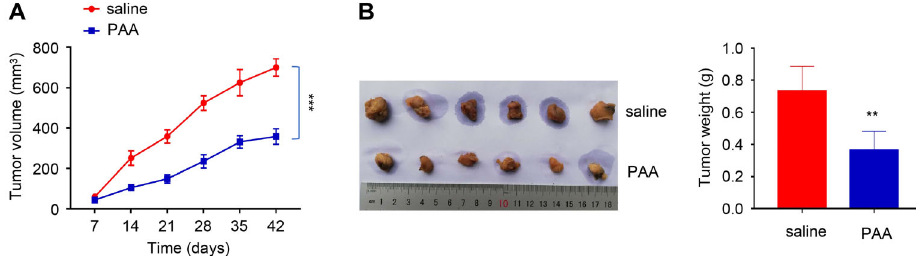
Figure 4. Poricoic acid A (PAA) treatment showed anti-tumorigenesis effects in xenograft model. A , SKOV3 cells were injected subcutaneously into female nude mice. The tumor volumes in mice fed with saline and mice with daily PAA intake were measured at 7, 14, 21, 28, 35, 42 days (n=6). ***P o 0.001, two-way ANOVA with Bonferroni post hoc test. B , Mice were sacri fi ced on day 42 and the tumor weight was compared between saline and PAA treatment groups. Data are reported as means ± SD. **P o 0.01, Student ’ s t